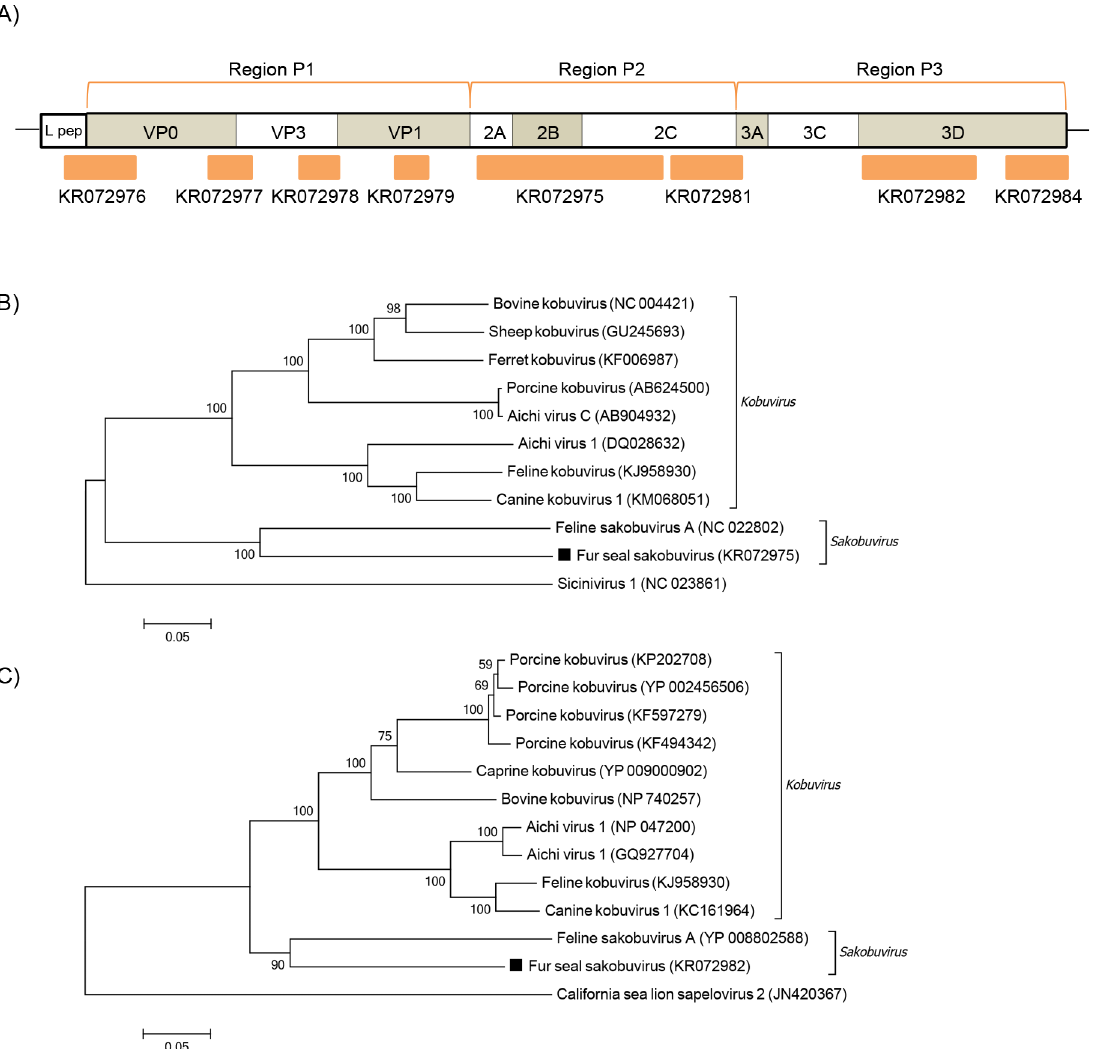
Fig 6. Phylogenetic analysis of fur seal sakobuvirus. (A) Schematic representation of the sakobuvirus genome using Feline sakobuvirus A (~7.8 kb — NC_022802) as a reference. The orange bars represent the contigs from Subantarctic fur seal. (B) Neighbor-joining phylogenetic tree based on the alignment of partial amino acid sequences (409 aa) from the P2 region of the polyprotein of 11 picornaviruses. Sicinivirus 1 was used as outgroup. (C) Neighbor-joining phylogenetic tree based on partial amino acid sequences (255 aa) from the 3D region of the polyprotein of 13 picornaviruses. California sea lion sapelovirus 2 was used as outgroup. The sakobuvirus sequences from the Subantarctic fur seal from this study used in phylogenetic analyses are labeled with a black square. The GenBank accession numbers of the viral sequences are shown in